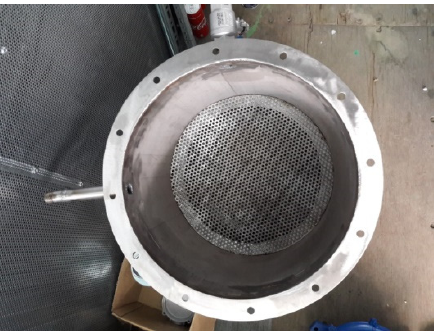
Figure 7. Desulphurizer—interior, volume of 50 L [photo by Grzegorz Wa ł owski]. A coal mixture (activated carbon) with turf ore (iron compounds) was developed, which allows for 100% desulfurization of raw agricultural biogas under process conditions for mesophilic fermentation—Figure 8.